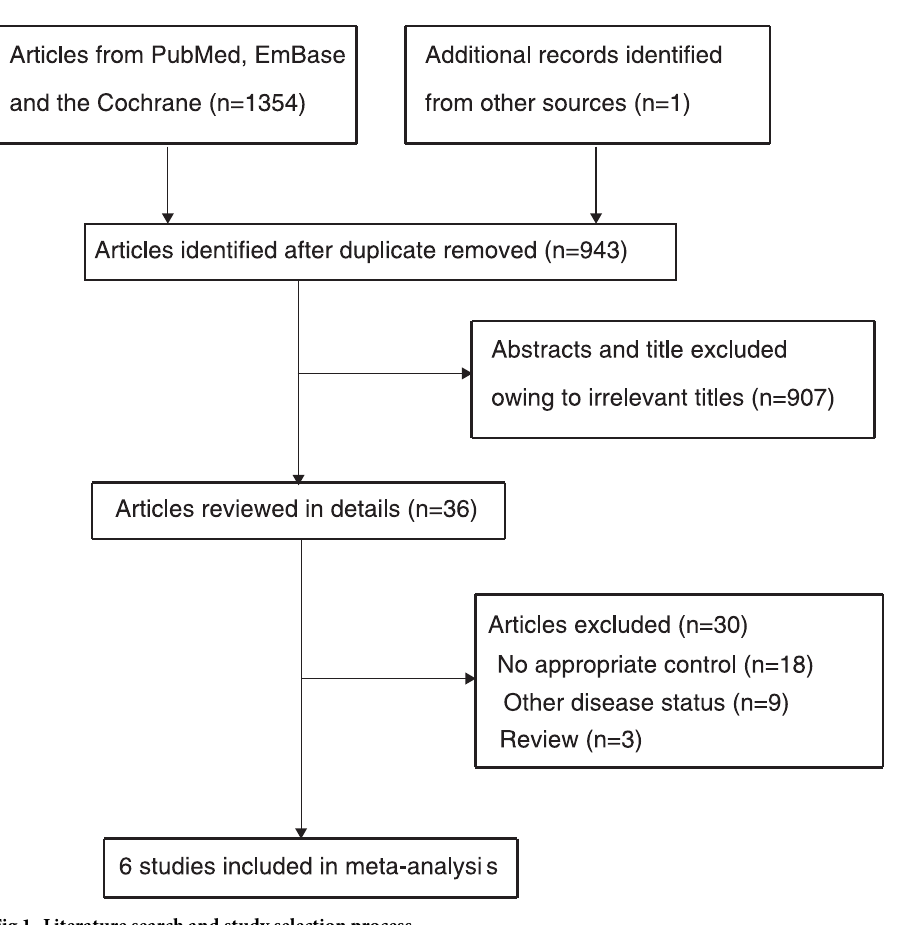
Fig 1. Literature search and study selection